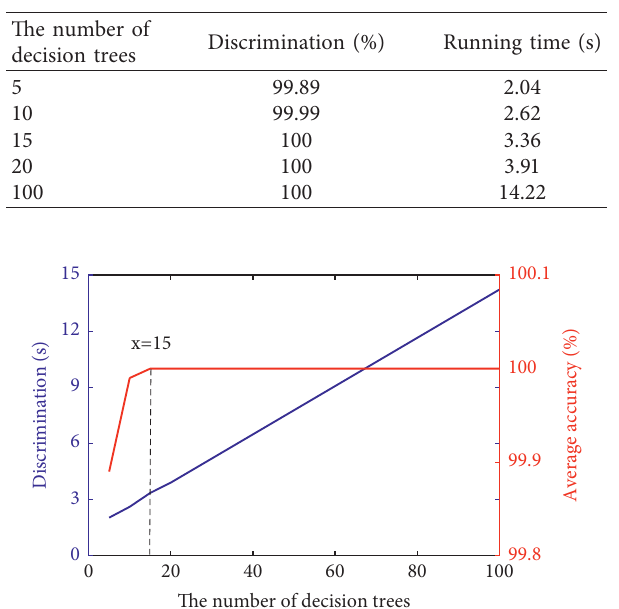
Figure 8: Running time of different decision trees. Table 3: Comparison of identification results of different models. Random